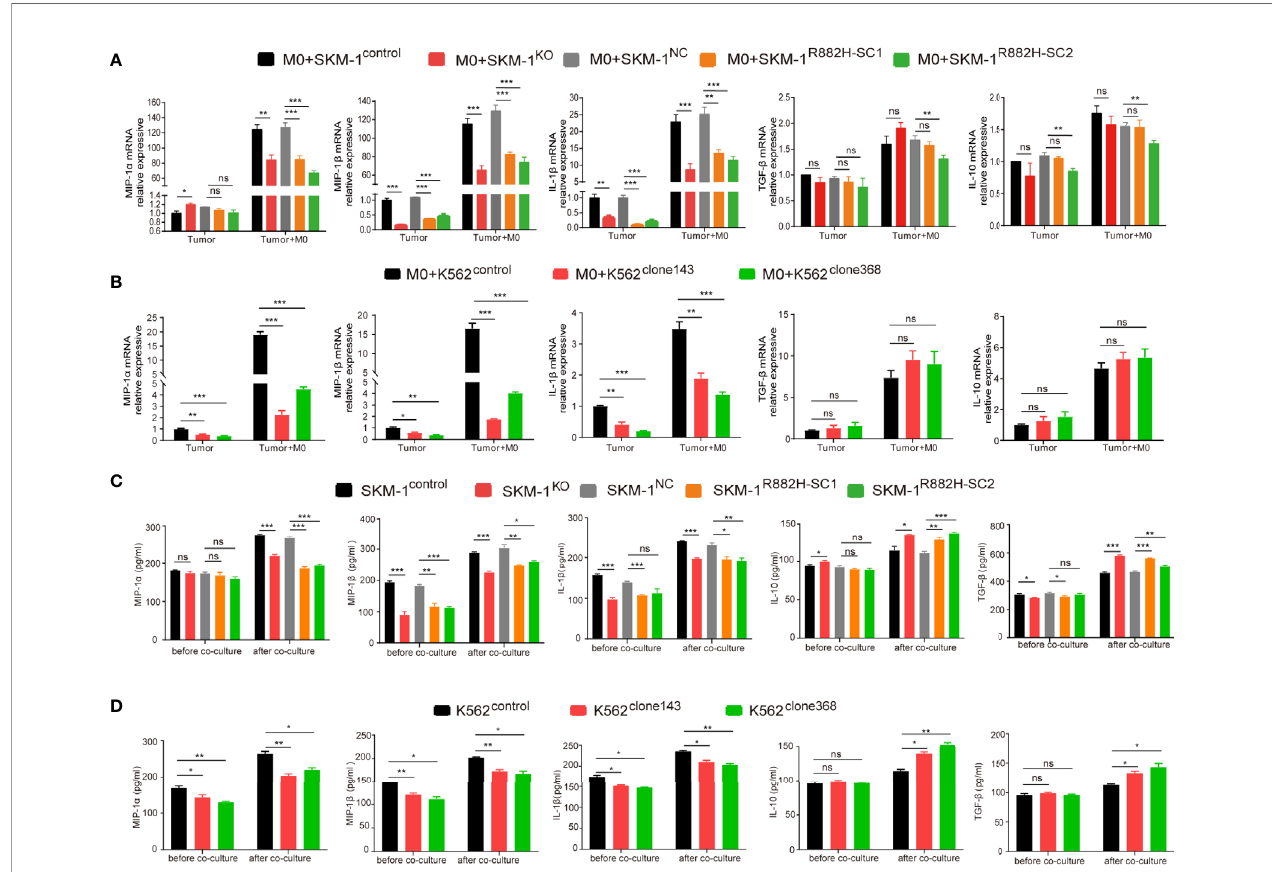
FIGURE 5 | DNMT3A mutation inhibits the expression of pro-in fl ammatory factors in AML cells and inhibits anti-tumor immunity. (A, B) The mRNA expression of MIP-1 a , MIP-1 b , IL-1 b (pro-in fl ammatory factors) and TGF- b , IL-10 (immunosuppressive factors) was measured by qRT-PCR in SKM-1 cells and K562 cells respectively after co-cultured with macrophages. (C, D) The secretion of in fl ammatory factors in the co-cultured supernatant was measured by ELISA. All the results are presented as mean ± standard deviation of three independent experiments (n = 3). *p < 0.05, **p < 0.01, and ***p < 0.0001 represent signi fi cant differences compared with the control. ns, no signi fi